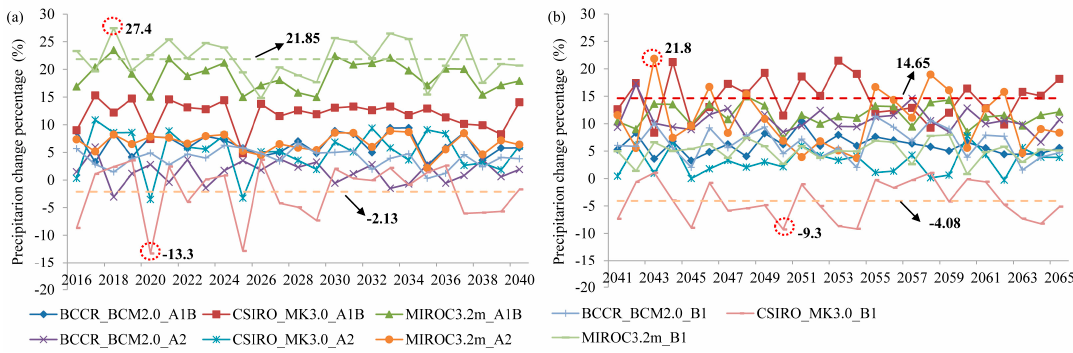
Figure 9. The forecasted precipitation change percentage relative to 1980–2004 period under CMIP3